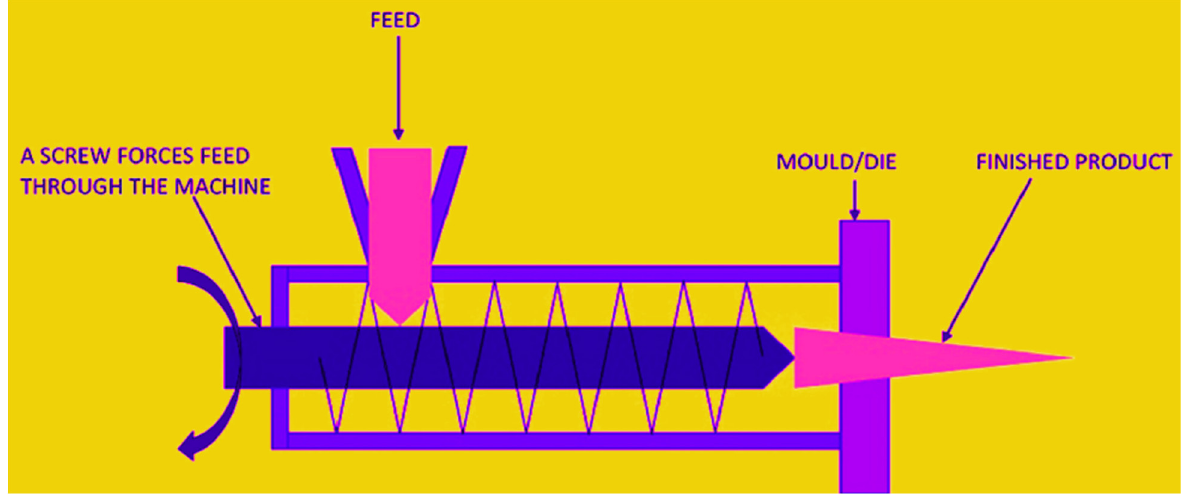
Figure 5. Extrusion technology of film formation from marine biopolymers. Adopted from [194] with permission. Table 2. Film formation methods for food products from marine biopolymers. Biopolymer